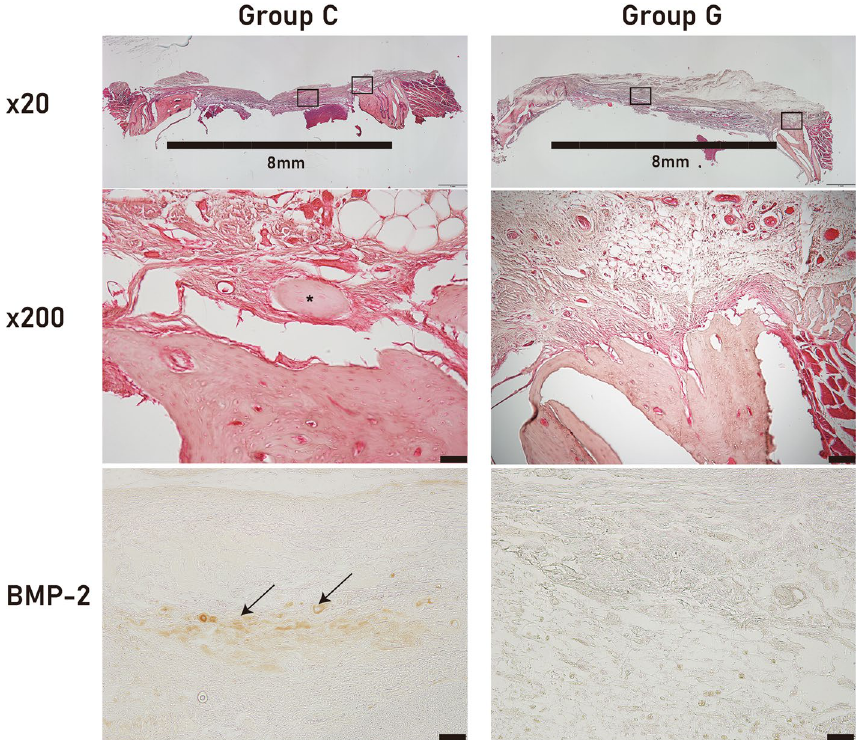
Fig. 3 Histological analysis. The original bony defect had been prepared as 8 mm (bar in low magnification view). The residual bony defect area at 8 weeks postoperatively in the collagen group (group C) was smaller than in the gelatin group (group G). Bone regeneration from the margin was examined with high magnification view. The view of group C at high magnification showed a regenerated bony island (*). The view of group C under high magnification also showed bone ingrowth into the defect (hematoxylin and eosin stain, bar in high magnification expression level of BMP‑2 was observed in the middle of bony defect. The expression level of BMP‑2 was also higher in group C than in group G